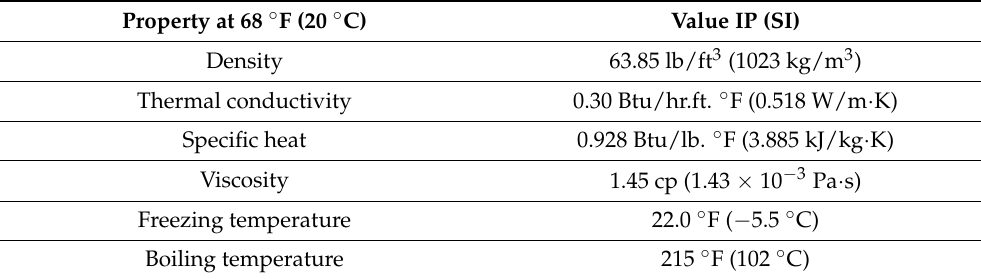
Table 3. Thermophysical properties of the working fluid used for S-GHSP